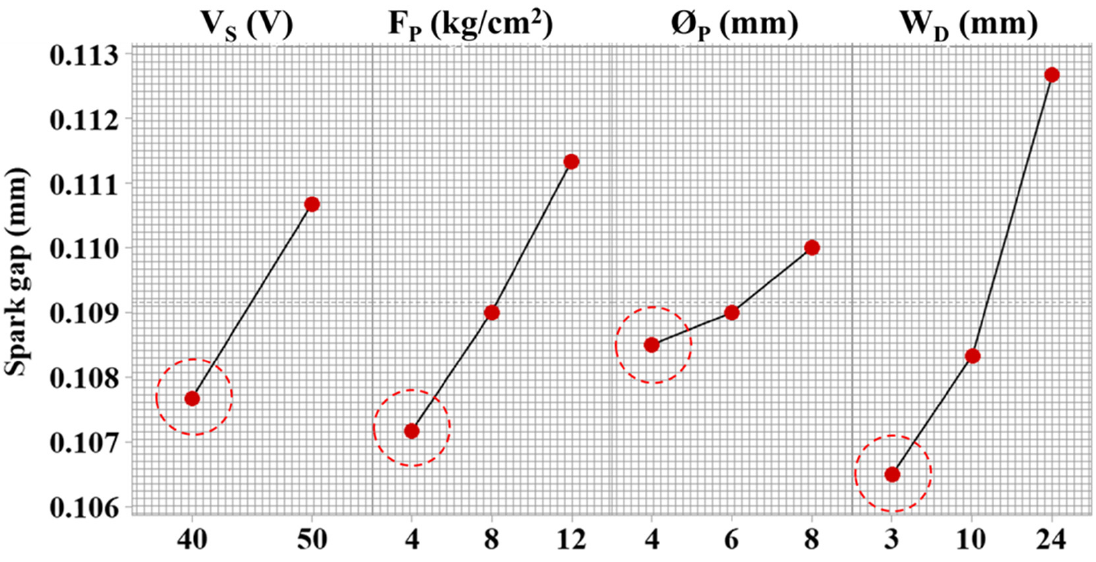
Figure 9. Parametric effects on spark gap formation of complex profiles machining and red circles indicating desired parametric level.